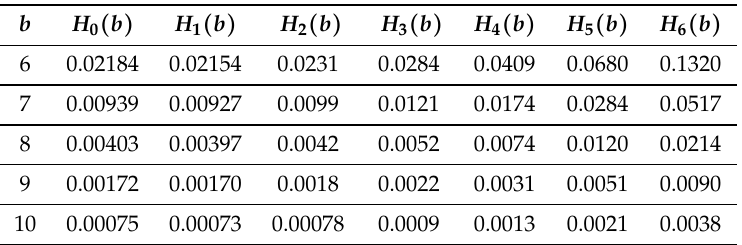
Table 1. Critical ratios in